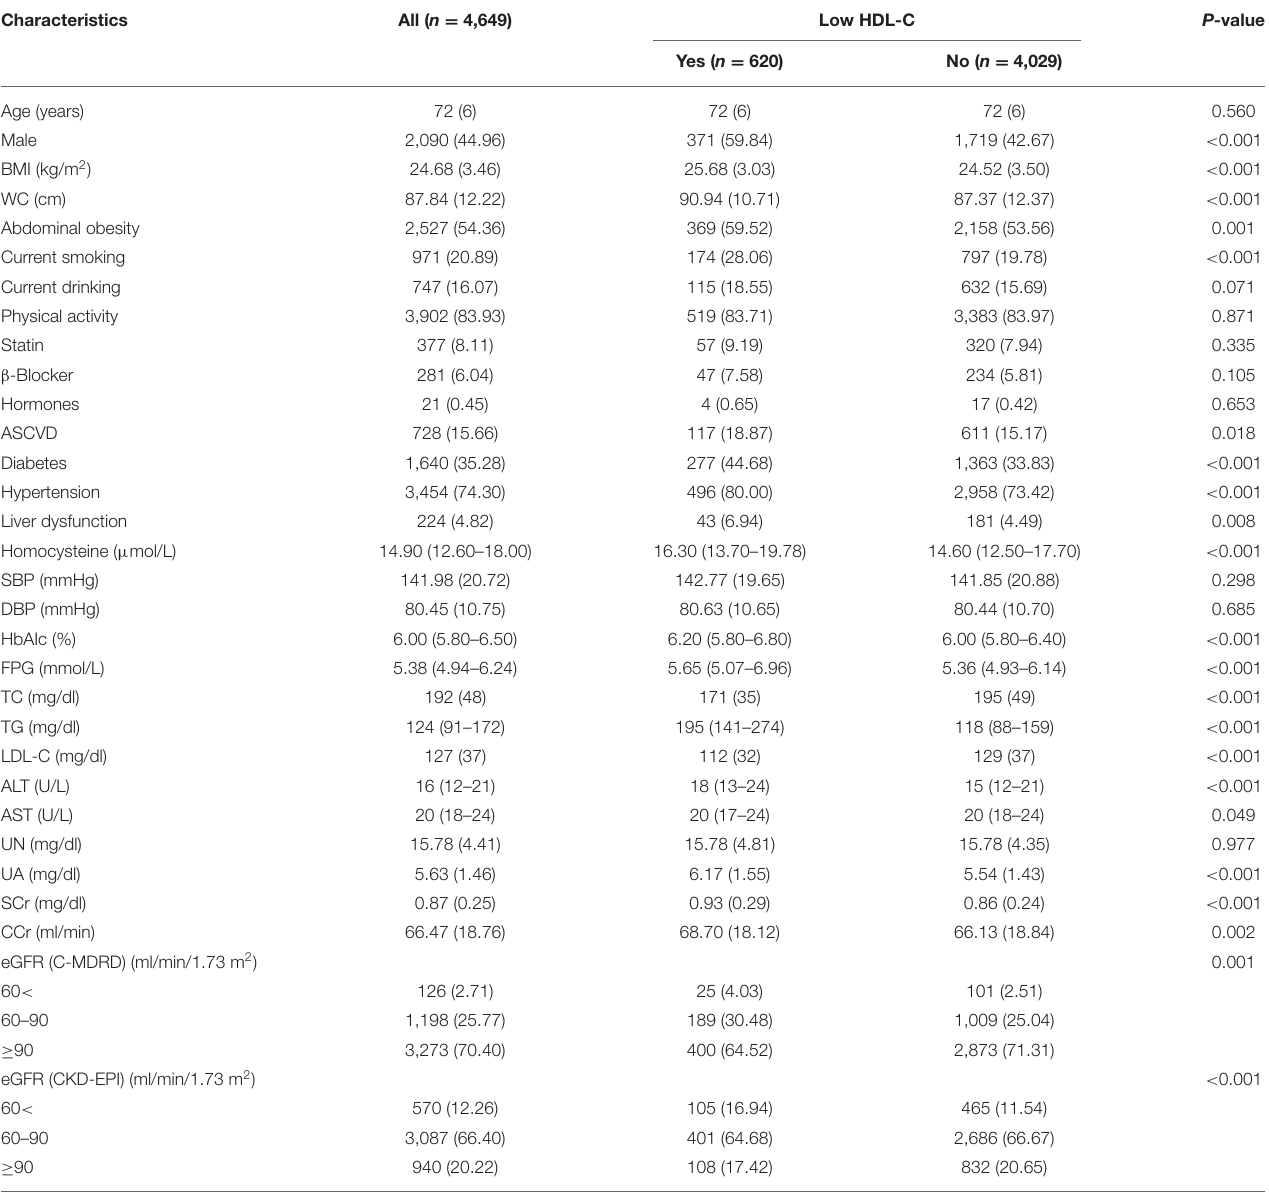
TABLE 1 | Baseline characteristics of participants according to low HDL-C